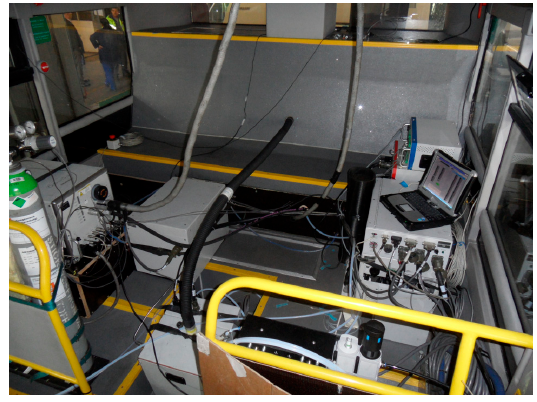
Figure 3. Installed Portable Emissions Measurement System (PEMS) for gas and PM 10 measurements on the DE5 bus.